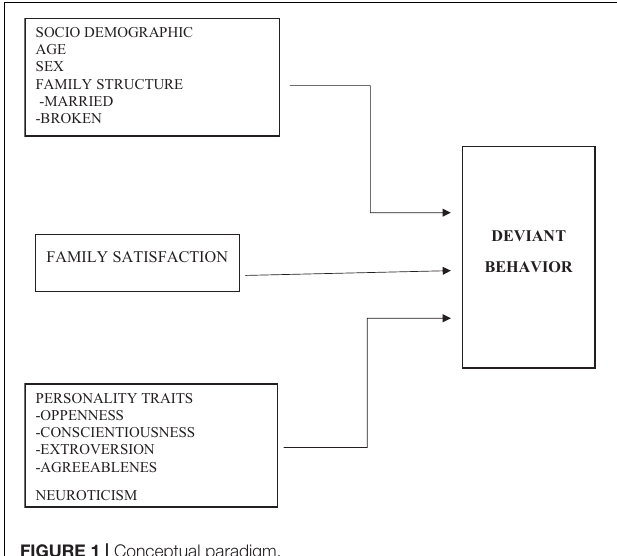
FIGURE 1 | Conceptual